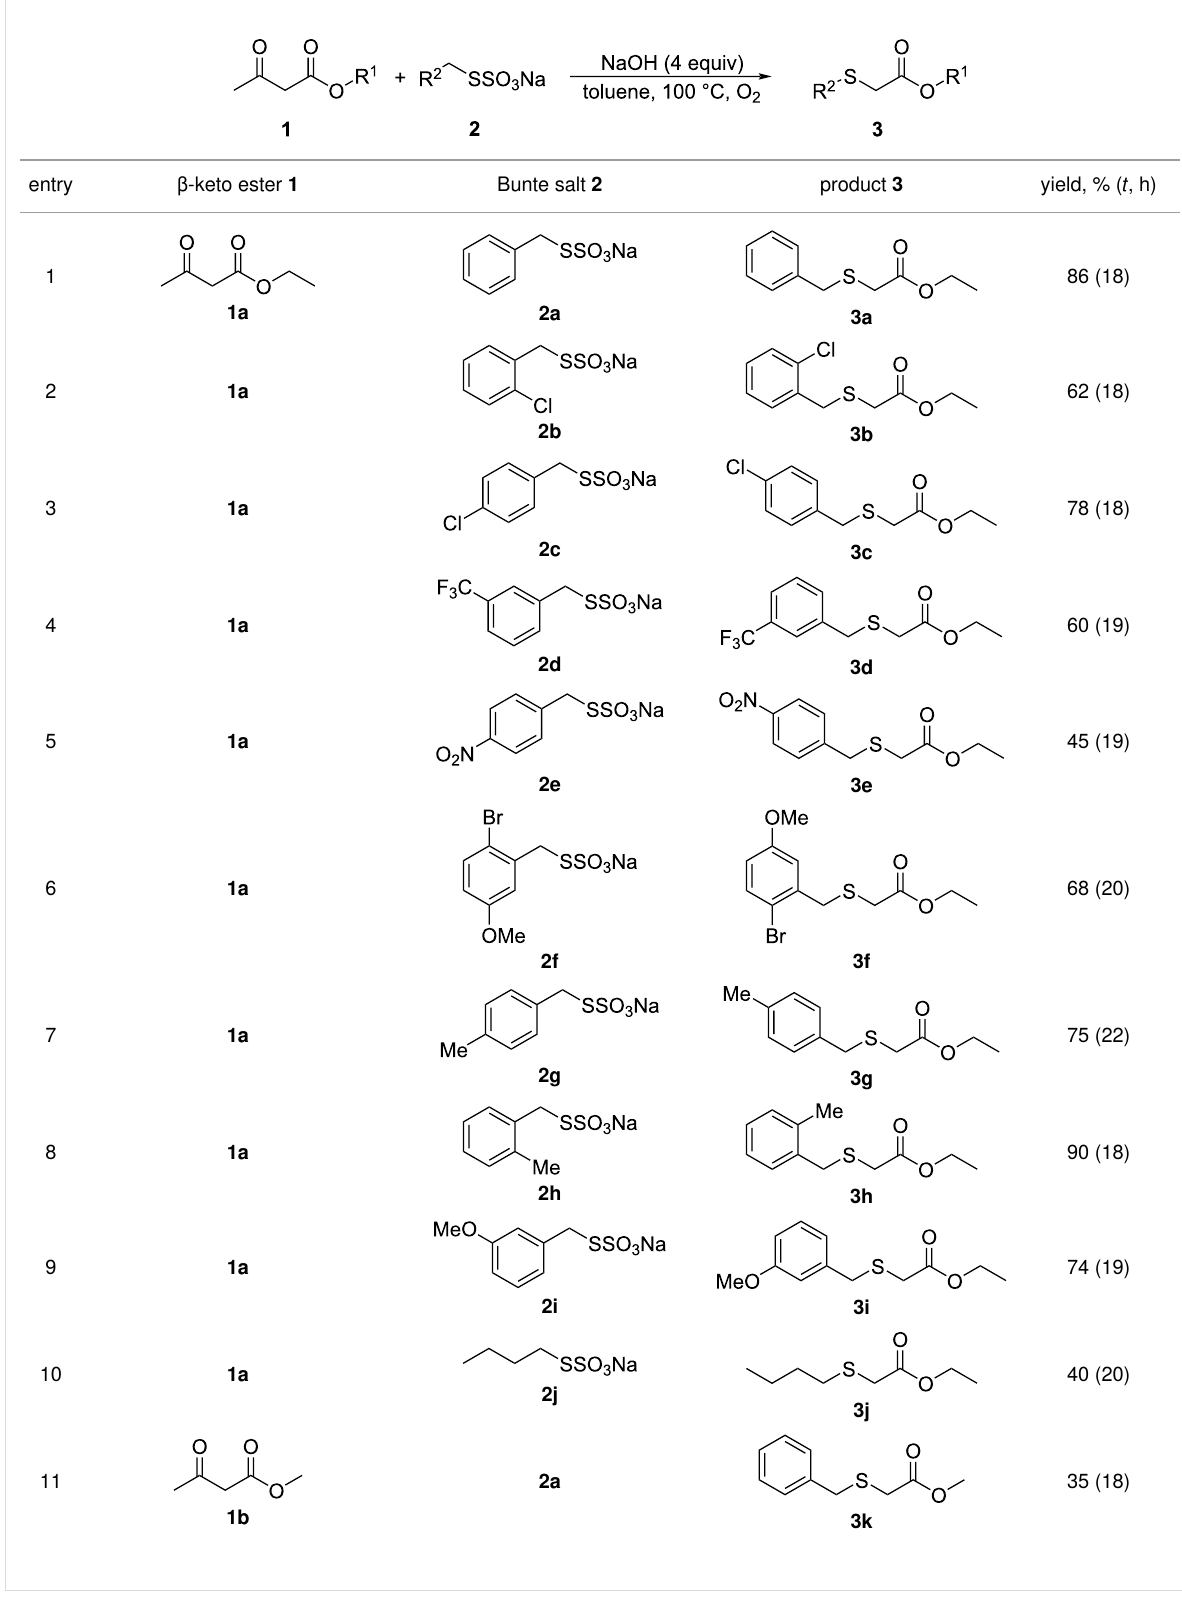
Table 2: Substrate scope for the synthesis of the α -organylthio esters 3 . a